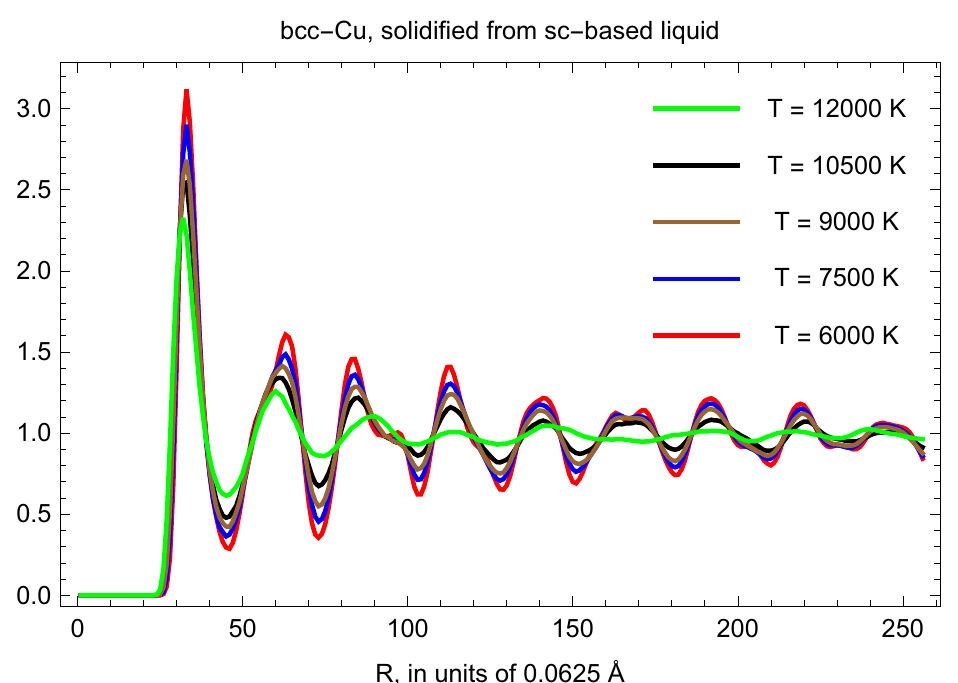
Figure 6. Radial distribution functions (RDFs) of the final states of the solidification of liquid Cu at ∼ 400 GPa at higher